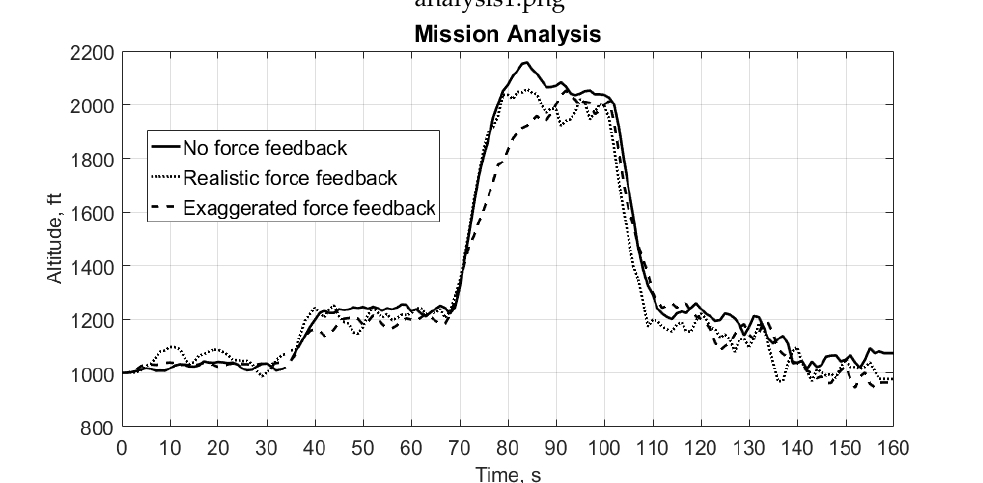
Figure 8. Mission